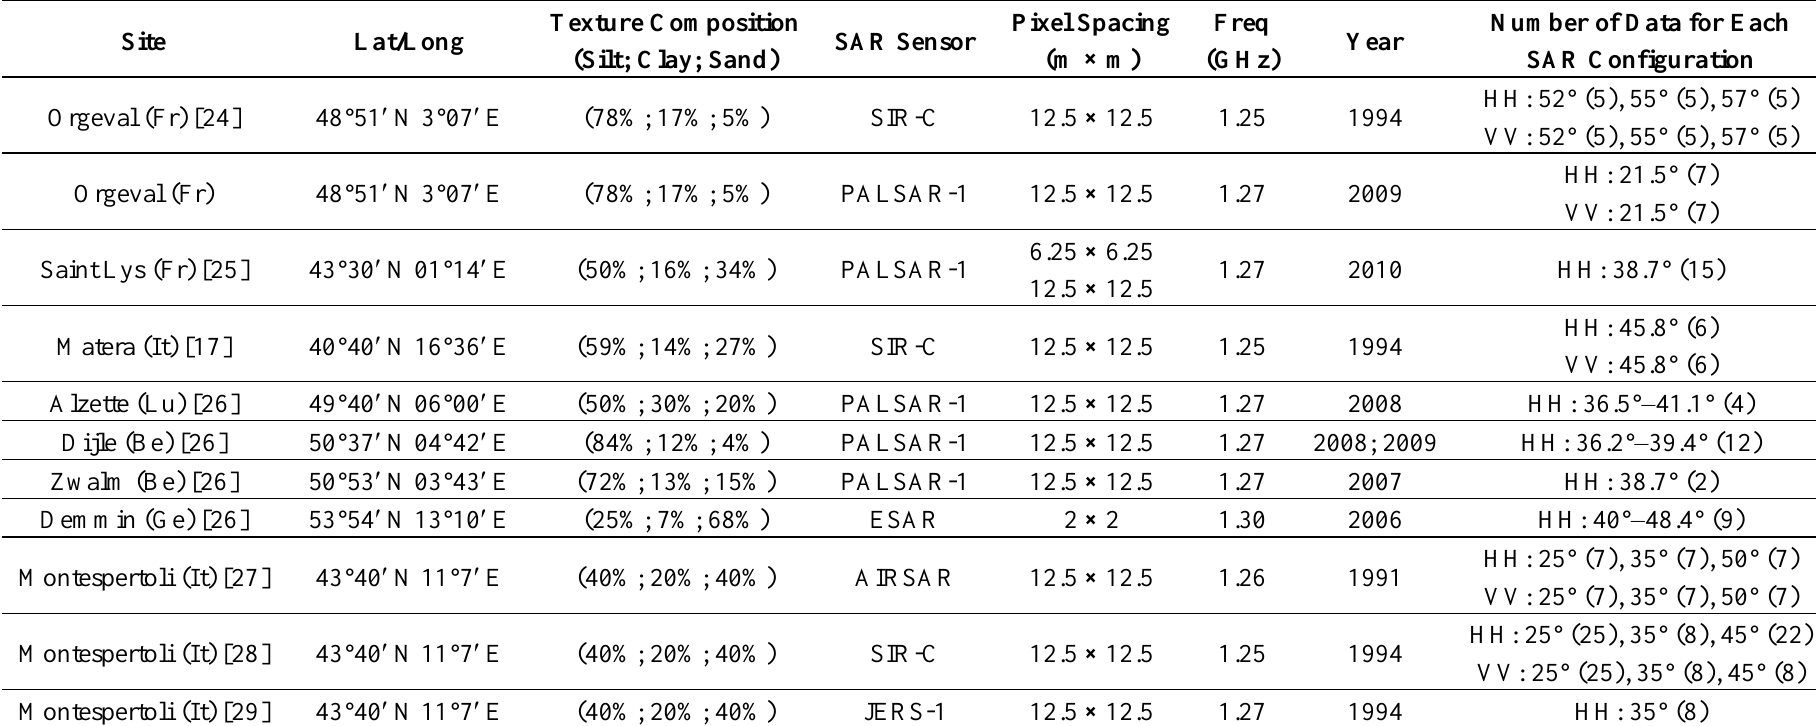
Table 1. Main characteristics of the dataset used in this